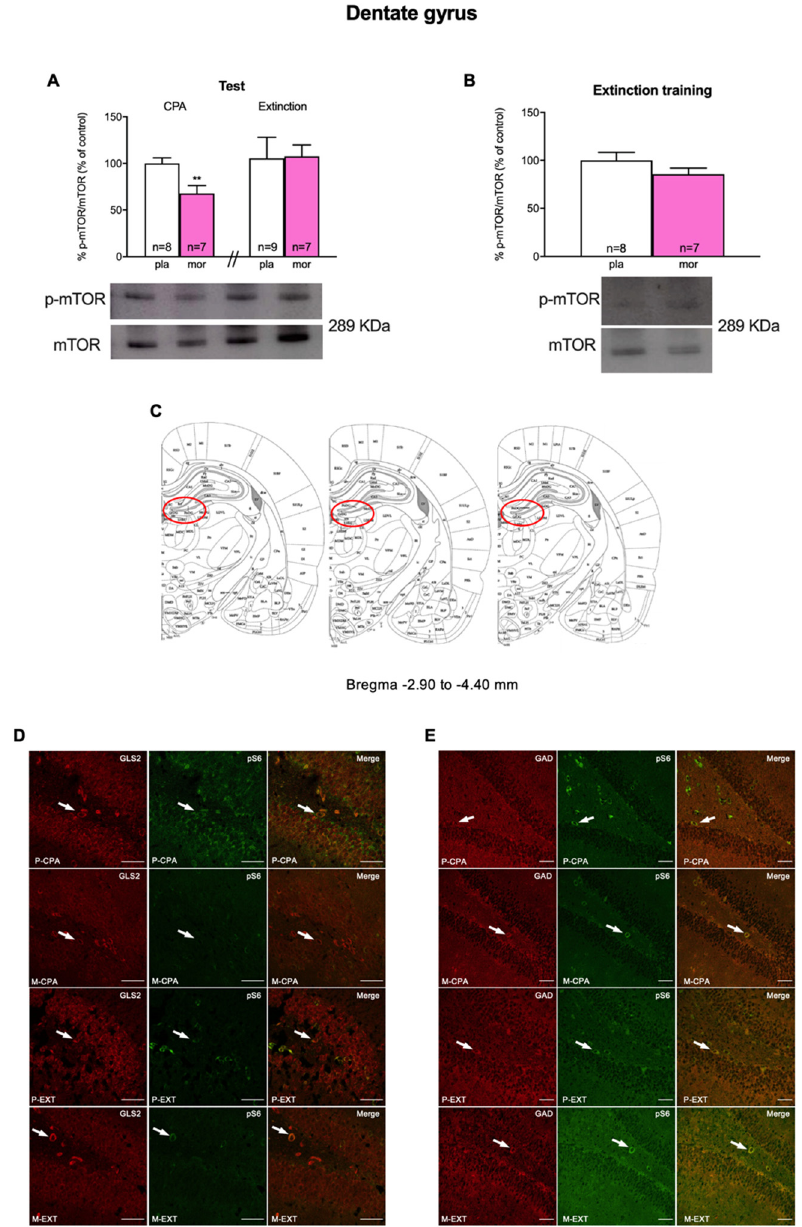
Figure 3. Dentate gyrus: ( A ) pmTOR/mTOR Western blot analysis after CPA and extinction tests.